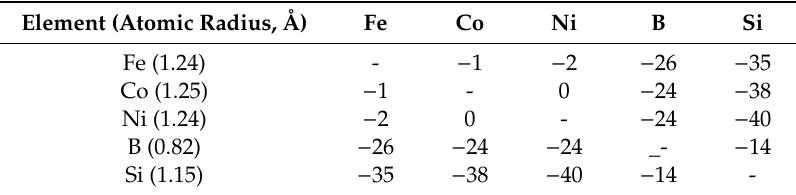
Table 2. Enthalpy of mixing ( ∆ H mix (kJ mol − 1 )) in binary equiatomic alloys calculated with Miedema’s approach [42].